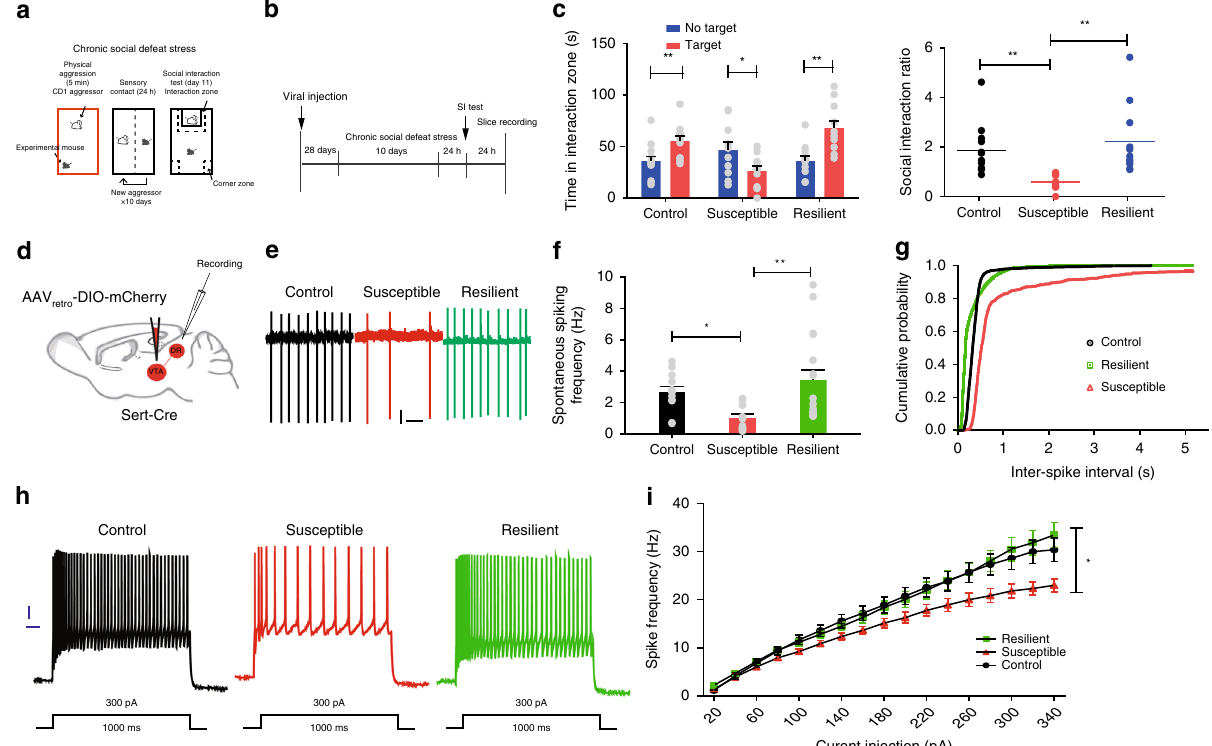
Fig. 3 5-HT DR → VTA neurons from susceptible mice show reduced fi ring activity. a , b Behavioral paradigm ( a ) and experimental timeline ( b ). c Left, time in the interaction zone in control mice ( n = 12; one-way ANOVA , F 1,22 = 8.319, P = 0.009) and resilient mice ( n = 11; one-way ANOVA , F 1,20 = 13.985, P = 0.001) was signi fi cantly increased when a target was present, whereas it was signi fi cantly decreased in susceptible mice ( n = 11; one-way ANOVA , F 1,20 = 5.125, P = 0.035). Right, the interaction ratio was signi fi cantly decreased in susceptible mice (control, susceptible, and resilient, n = 12, 11, and 11 mice; one- way ANOVA, post hoc LSD, F 2,31 = 7.901, control vs susceptible: P = 0.005, susceptible vs resilient: P = 0.001). d Schematic for labeling 5-HT DR → VTA neurons. e Representative fi ring of 5-HT DR → VTA neurons from control (black), susceptible (red), and resilient (green) mice after CSDS. Scale, 20 pA, 1 s. f Spontaneous fi ring frequency of 5-HT DR → VTA neurons decreased in susceptible mice compared with both control and resilient mice ( n = 12, 12, and 17 cells from 5, 5, and 4 control, resilient, and susceptible animals, respectively; one-way ANOVA, post hoc LSD, F 2,38 = 5.218, control vs susceptible: P = 0.046, susceptible vs resilient: P = 0.003). g Interspike intervals were calculated from each neuron fi ring, and the data in f were presented in a cumulative frequency. h Current-clamp traces of 5-HT DR → VTA neurons from control, susceptible, and resilient animals in response to a 300 pA depolarizing step. Scale, 10 mV, 100 ms. i The fi ring frequency (Hz) of 5-HT DR → VTA neurons from susceptible mice was reduced compared with both control and resilient mice, indicating reduced excitability ( n = 14, 15, and 14 cells from 5, 4, and 4 control, resilient, and susceptible animals, respectively; two-way ANOVA, post hoc LSD, F 2,40 = 3.288, control vs susceptible: P = 0.044, susceptible vs resilient: P = 0.024). Data are represented as mean ± SEM; * P < 0.05, ** P < 0.01. Source data are provided as a Source Data fi